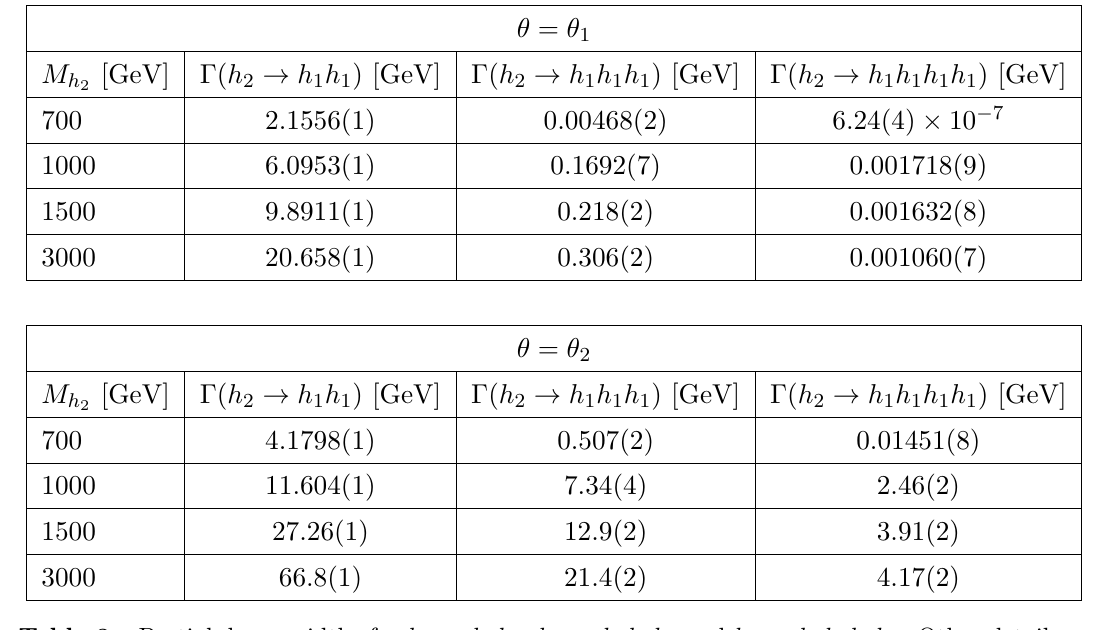
h h h 1 1 1 and